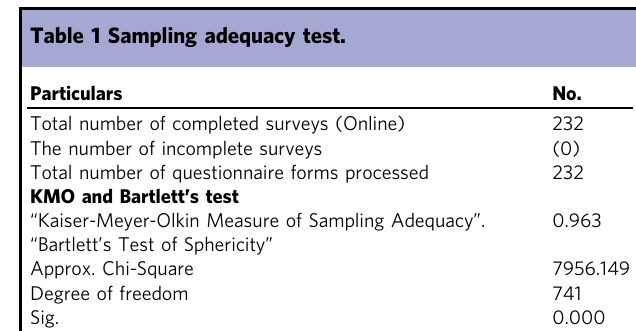
Fig. 1 Research framework. The research framework comprises three main variables: CGC, BCM, and ITG. CGCs are considered independent variables measured by board size, board independence, board diligence, audit committee independence, audit committee diligence, board committees, and external audit. BCM is treated as the independent variable, and ITG is a moderating variable.